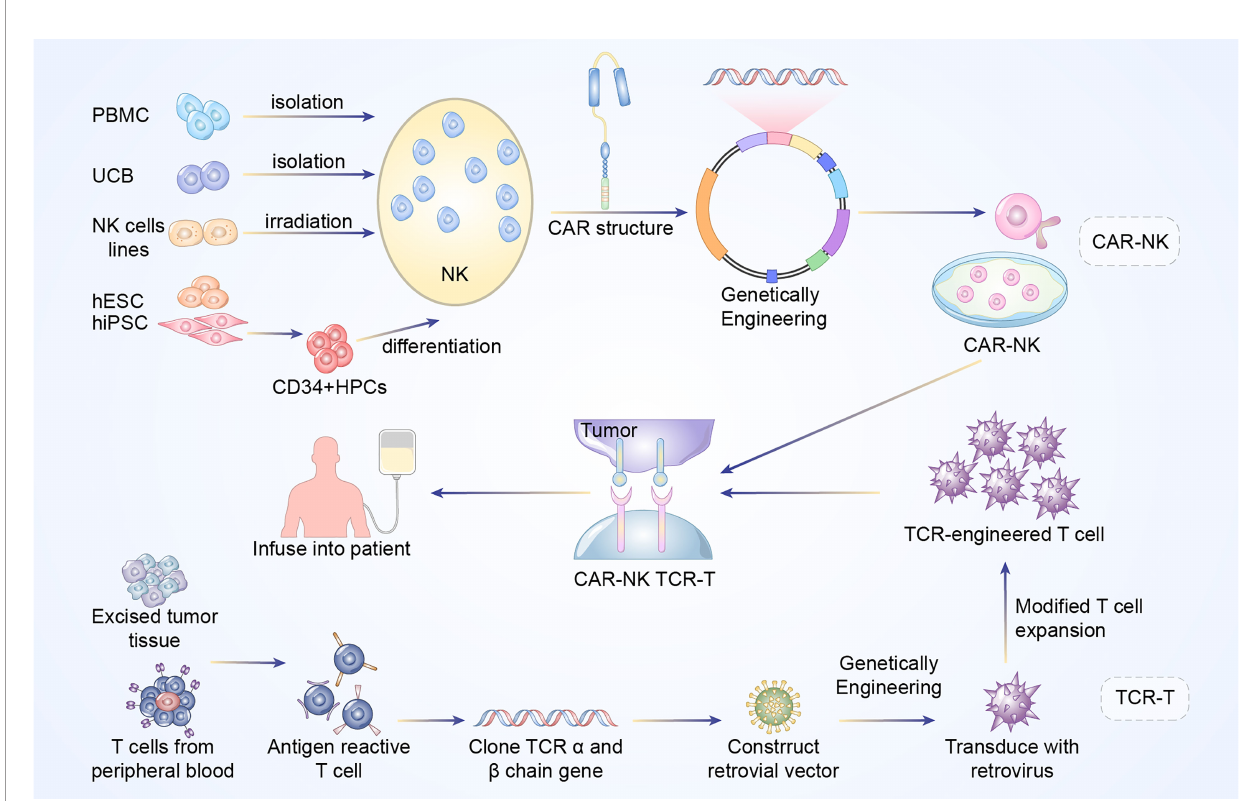
FIGURE 1 | Manufacturing procedures of CAR-NK and TCR-T cells. The established NK cells principally come from PBMC, UCB, NK cell lines, ESCs, and iPSCs. The NK92 cell line after irradiation has been widely used as the main source of CAR-NK cells. In addition, primary NK cells could be extracted from peripheral blood (PB) or umbilical cord blood (UCB). The above NK cells are engineered with CAR structure to produce CAR-NK cells. Antigen reactive T cells are isolated from excised tumor tissues or PB of the patients. Subsequently, the antigen-speci fi c TCR sequences are cloned and transfected into T cells via retroviral or lentivirus vector to construct TCR-engineered T